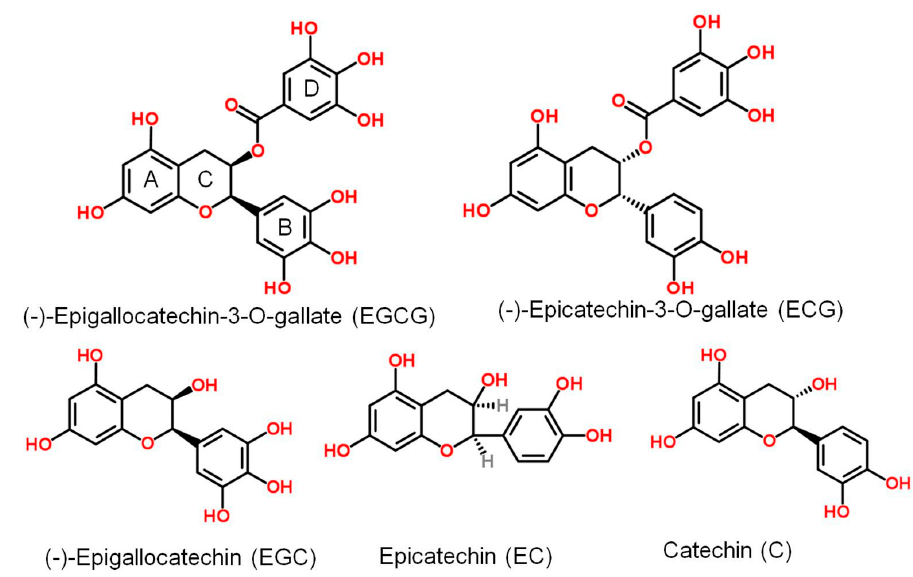
Figure 1. Structures of green tea catechins.